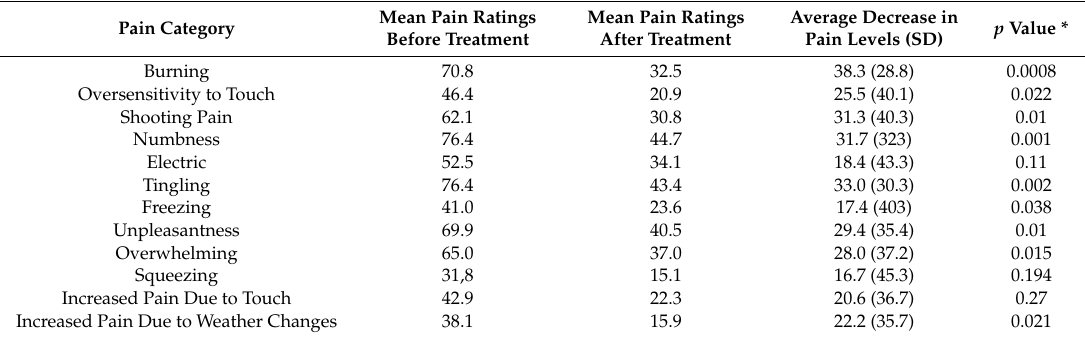
Table 4. Mean pain ratings before and after treatment of all participants and the average decreases in pain levels for the 12 pain descriptors (categories) of the neuropathic pain questionnaire (NPQ) 1 . Mean Pain Ratings Pain Category Before